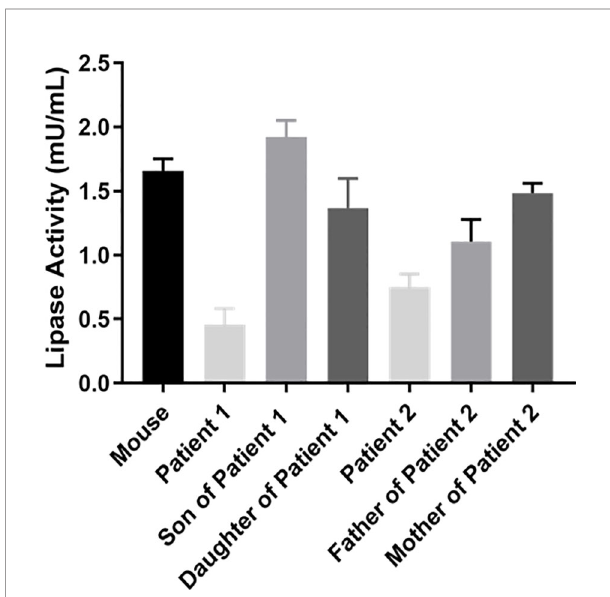
FIGURE 4 | Analysis of LPL activity in plasma. Peripheral blood was collected at 10 min after heparin injection (60 IU/kg) to assay lipase activity by the enzyme- fl uorescent